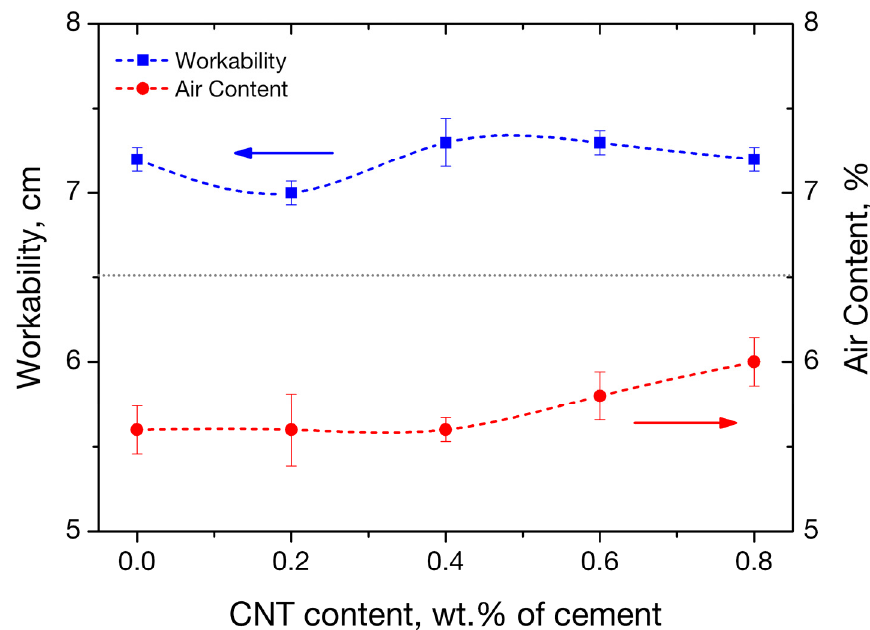
Figure 4. Change of flowability and air content across nano-modified mortars with different concentrations of carbon nanotubes.